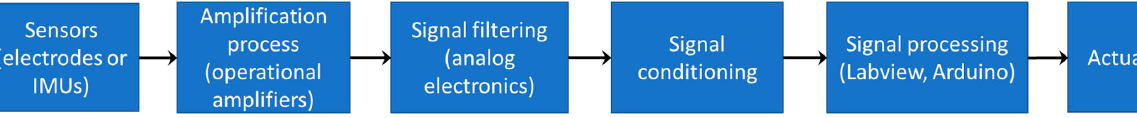
Figure 13. Control stage.